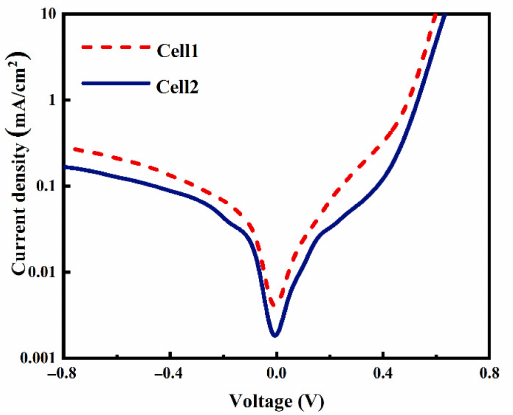
Figure 6. Dark J-V curves of the two cells using Ag-Al paste and firing-through Al paste. The microstructural properties of the Si/metallization interface are examined by SEM at 10 kV. SEM results confirmed that the damage to the Si wafer was caused by metal paste. The typical Ag-Al paste/Si substrate microstructure is shown in Figure 7a. The Ag-bulk/Si contact in p+ emitter has been studied in detail [9,11,12,16], and the glass frit can etch away the passivation layer through firing-through contact technology. As reported [13], the glassy-phase plays an important role in contact properties, in which regenerated nano- Ag particles are dissolved to form Ag colloids. The Ag colloids with the glassy-phase assist the current tunneling with the intention of realizing current transmission through the glass phase. The SEM image of the Si/metallization interface after the metal paste was removed is shown in Figure 7c. A continuous phase containing Ag colloids was observed at this region, which is the same as reported: that the combination influences of dissolved Ag particles and glassy-phase have crucial effects on the current transport across the interface [21].